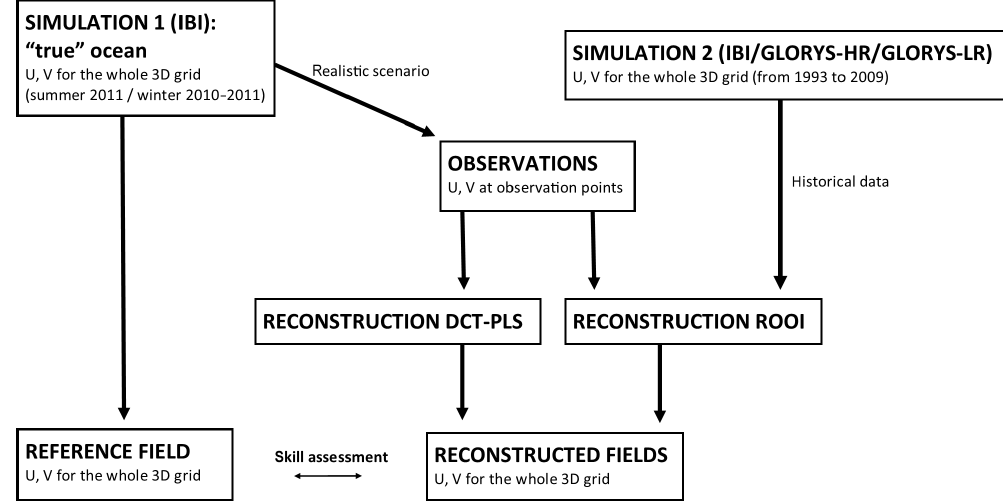
Figure 2. Scheme of the approach used to test the performance of the two data-reconstruction methods described in Sect. 2.2. The models used for SIMULATION 1 and SIMULATION 2 are presented in Sect.